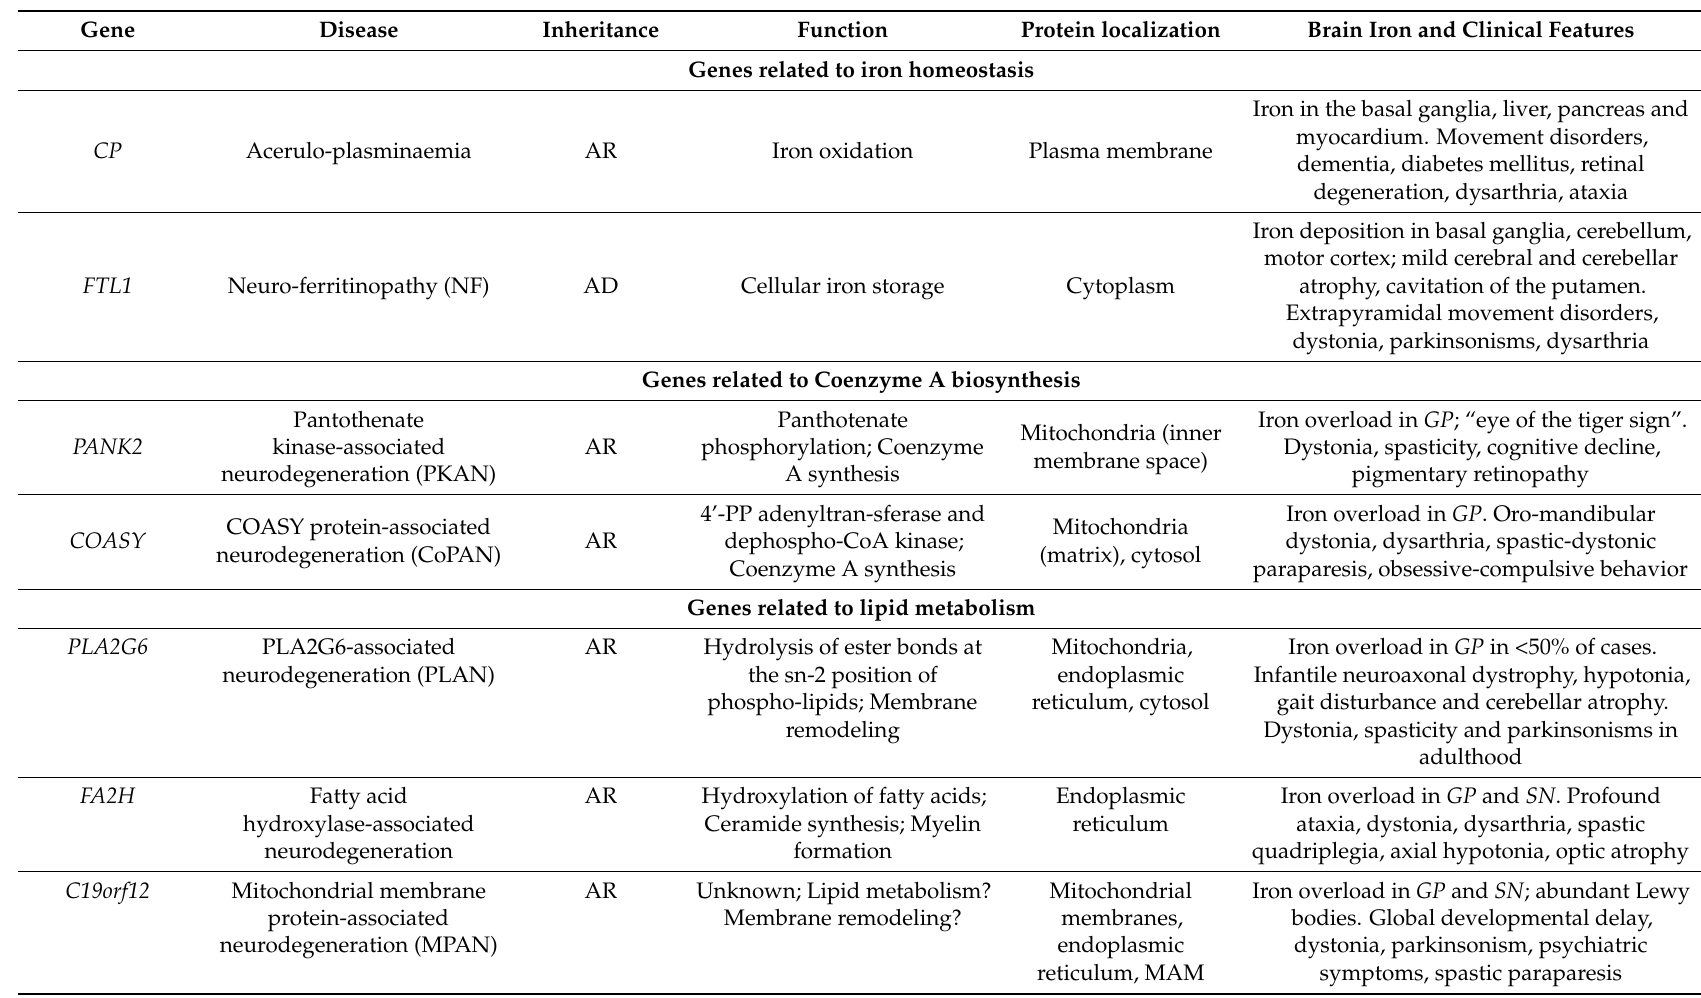
Table 1. Molecular and clinical features of NBIA